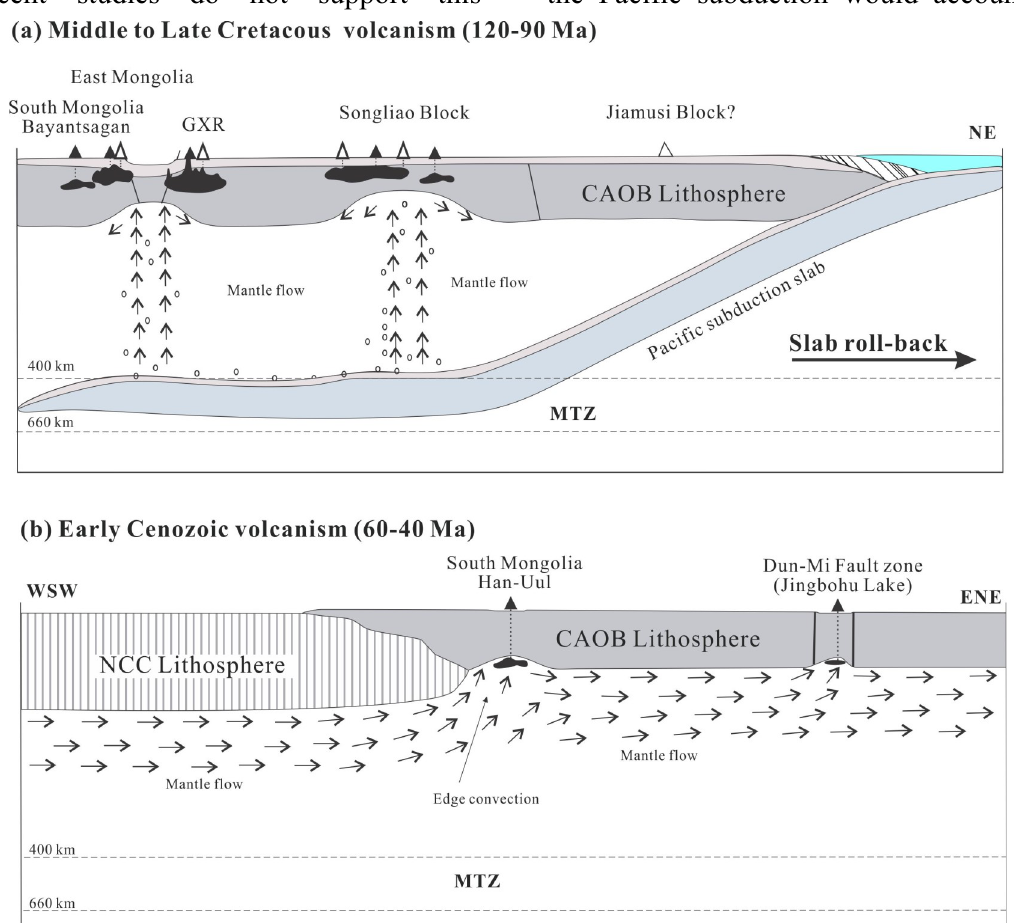
Fig. 11. Cartoon diagrams showing the possible petrogenesis and geodynamic settings in which the South Mongolian late Mesozoic-early Cenozoic basalt generated. (a) The model of back‐ arc extension, possibly induced by slab rollback of the westward subducted Pacific Plate and the subduction zone retreat, can explain the geodynamic setting of the Late Mesozoic volcanism in South and East Mongolia.(b) An edge convection model to explain the formation of the late Cretaceous-early Cenozoic volcanic rocks (60-40 Ma) in South Mongolia mainly along the juxtaposed margins of the NCC and CAOB. Melts from decompression melting of a small-scale shallow mantle upwelling reacting with the overlying lithosphere to produce the Han-Uul volcanic rocks in South Mongolia. MOO: Mongol-Okhotsk Ocean; DTGL: Daxing’anling-Taihangshang gravity lineation; CAOB: Central Asian Orogenic Belt; GXR-Great Xing’an